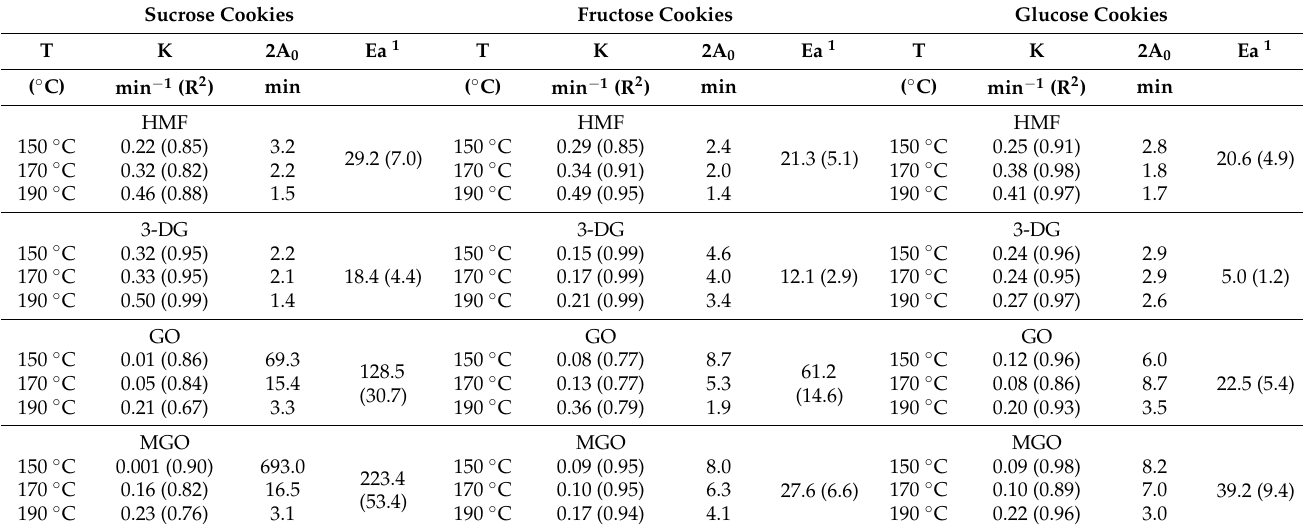
Table 3. Kinetic parameters for HMF and DC formation in